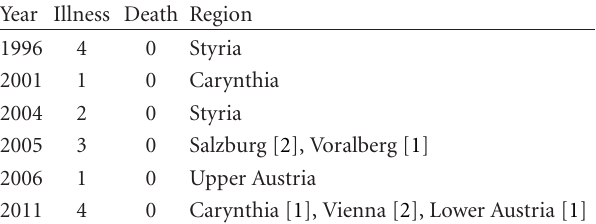
Table 1: Cases of botulism in Austria since 1990 [3,